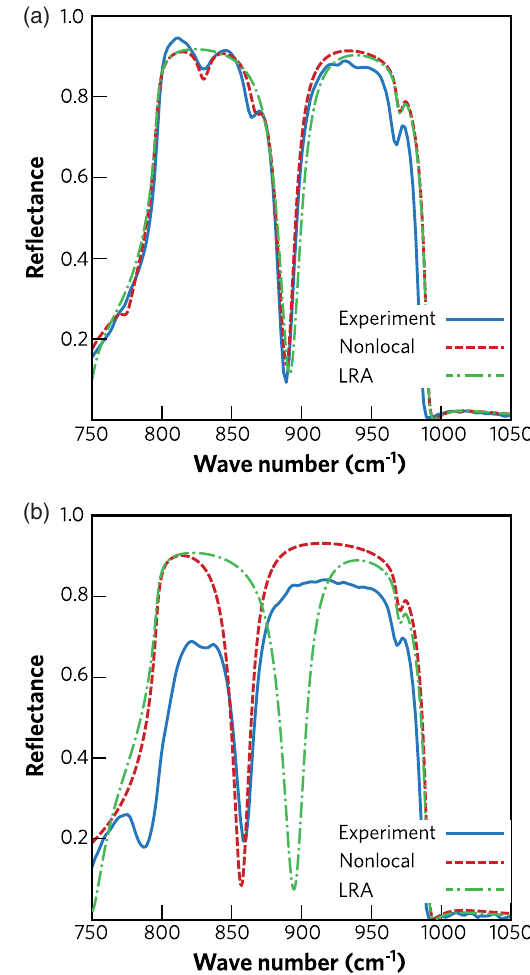
FIG. 5. Comparison of experimental reflectance data [31] (blue solid line), a local dielectric description (green dot-dashed line), and a nonlocal description (red dashed line) of nitride super- lattices. Panel (a) shows results for heterostructure A and (b) for heterostructure B as described in the